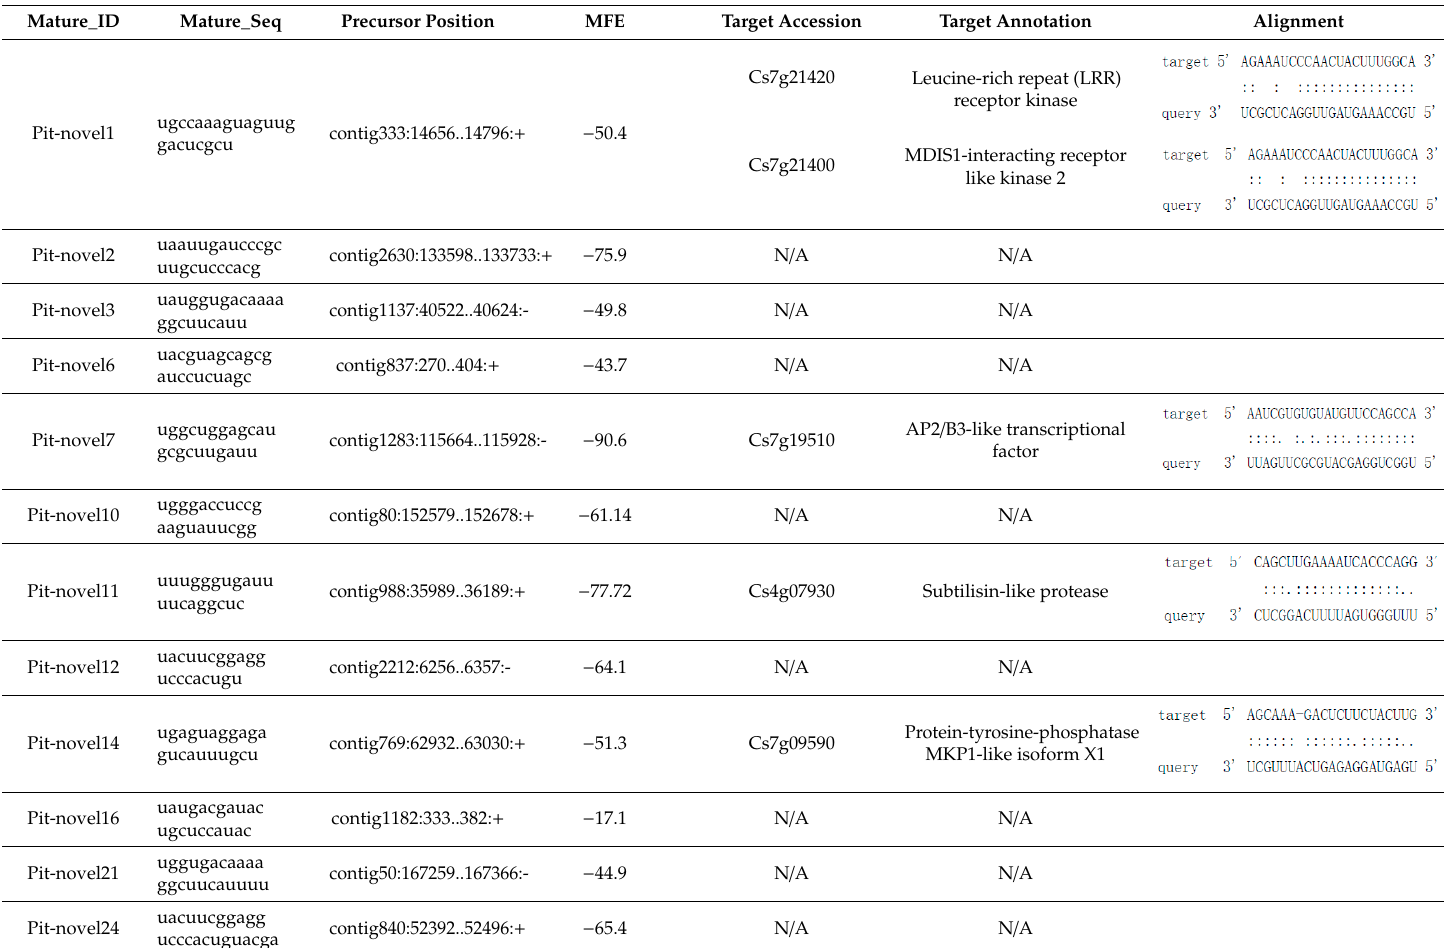
Table 1. Characteristics of the predicted novel milRNAs and their targets in Citrus sinensis.